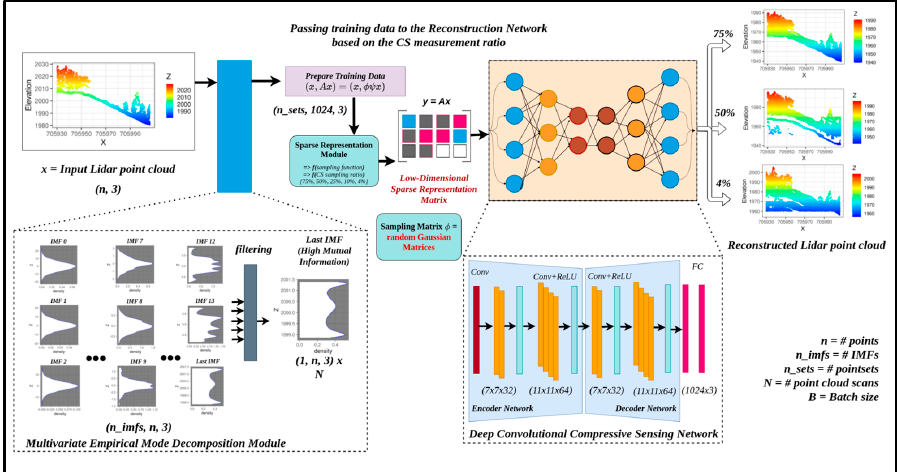
Figure 4. Illustration of workflow for our proposed ADCoSNet for 3D Reconstruction of LiDAR Point Clouds. The Multivariate Empirical Mode Decomposition Module illustrates the filtering of last IMF having high mutual information. The filtered signal is passed to train the deep convolutional compressive sensing network for obtaining the sparse representations. Once the sparse representations are obtained, the network can subsequently be used to reconstruct the 3D LiDAR point clouds.